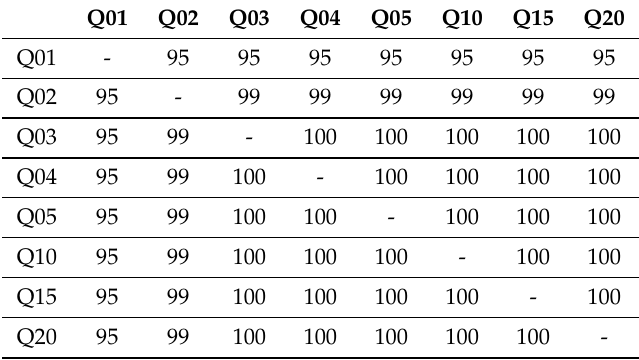
Table 8. Test results for similar plain text files with